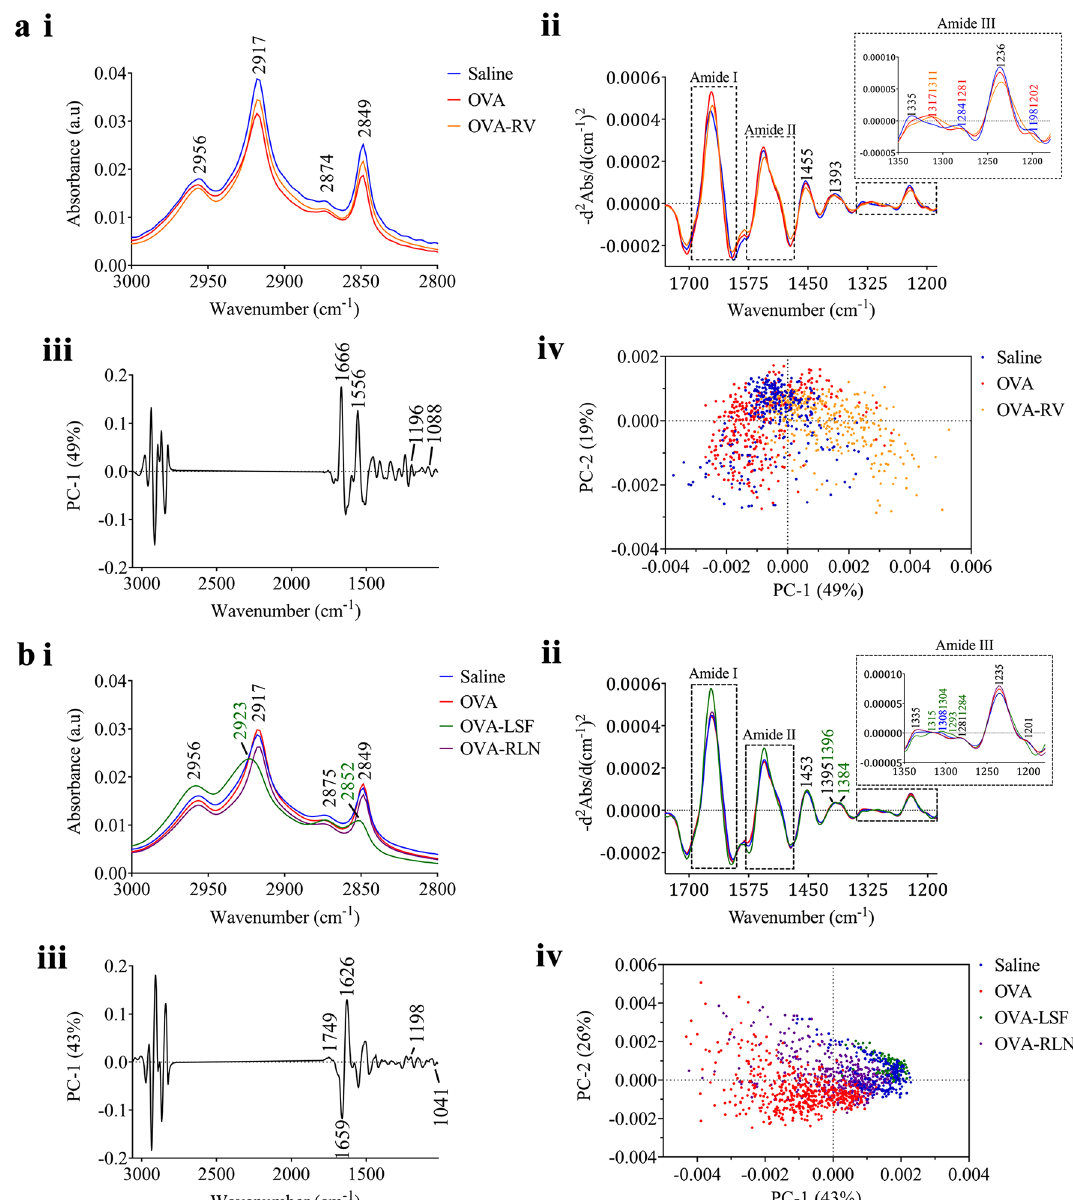
Figure 4. Average S-FTIR spectra and the corresponding PCA analysis obtained from the two models of allergic airways disease. PCA analysis based on S-FTIR spectra of the prevention (a) and reversal (b) models. The average absorbance (i) and inverted second derivative (ii) spectra obtained from each treatment group, accompanied by the resultant PCA analysis including loadings (iii) and scores (iv)